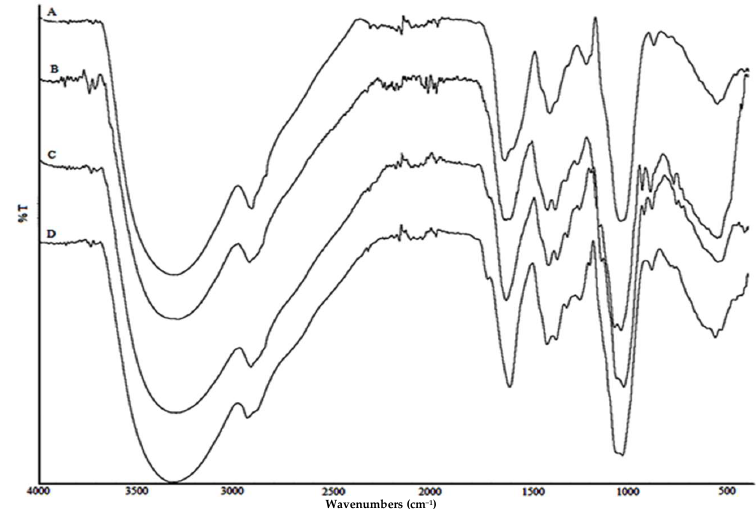
Figure 2. Fourier-transform infrared spectroscopy of polysaccharide samples isolated from S. commune. Type of extracts examined: A—filtrate, 14 days, F IT; B—mycelium, 14 days, M IT: C—mycelium, 14 days, M SRB; D—filtrate, 28 days, F